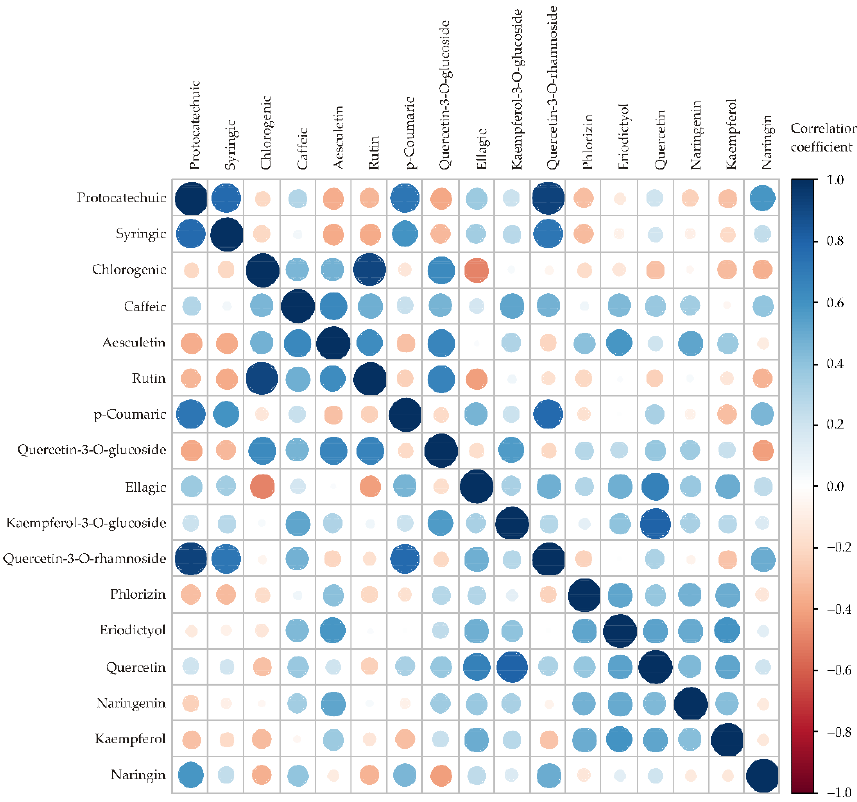
Figure A4. Color correlation graph between sugar contents in raspberry extract samples.